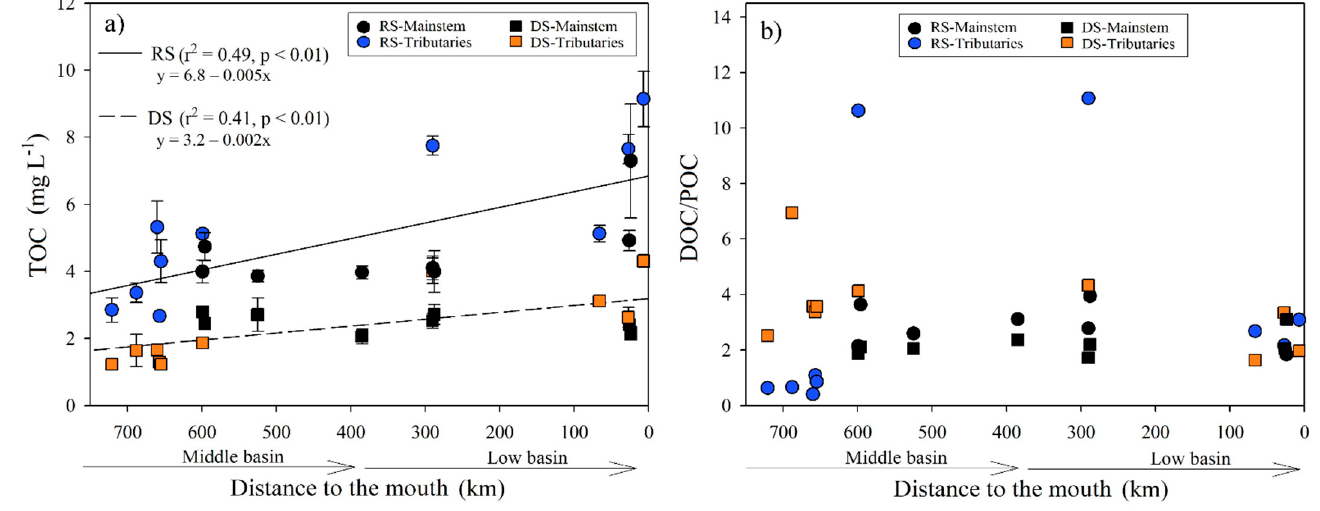
Figure 5. ( a ) Longitudinal variations in the TOC concentration (±SD) according to distance from the Usumacinta River’s mouth during the rainy (RS) and dry (DS) seasons; ( b ) longitudinal variations in the DOC/POC ratio according to distance from the mouth of the Usumacinta River during the rainy (RS) and dry (DS) seasons. The mainstem differs in both seasons from the tributaries.